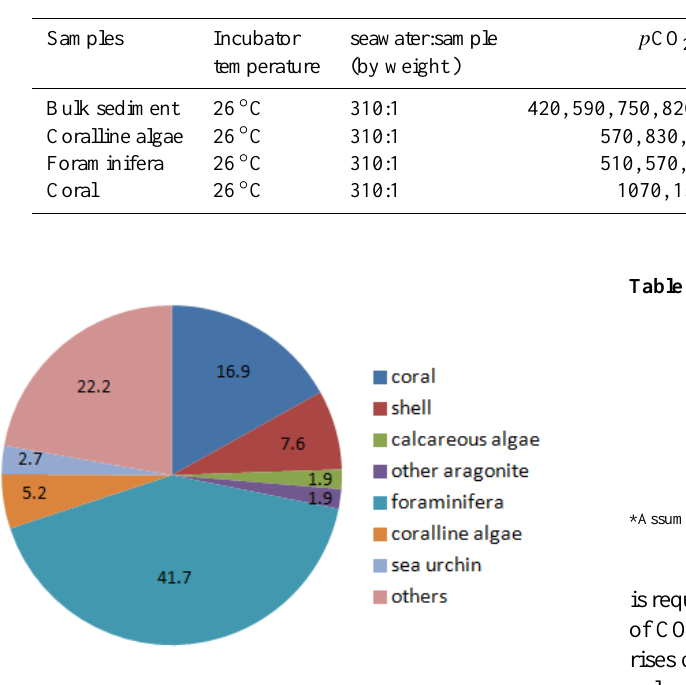
Fig. 2. Composition of sediment samples (%).